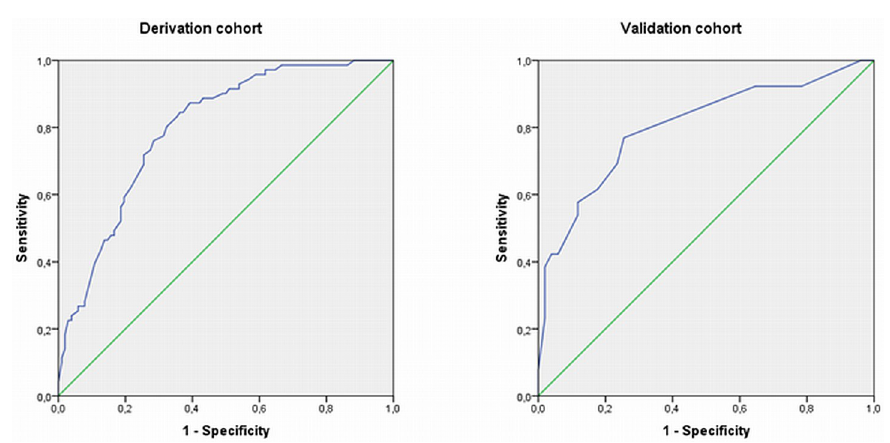
Fig 2. ROC curves for the prediction models of MTX insufficient response (DAS28 > 3.2) in the derivation (left panel) and validation (right panel) cohorts. Area under receiver operating characteristics curve was 0.80 (95%CI: 0.73–0.86) in the derivation cohort and 0.80 (95%CI: 0.69–0.91) in the validation cohort.